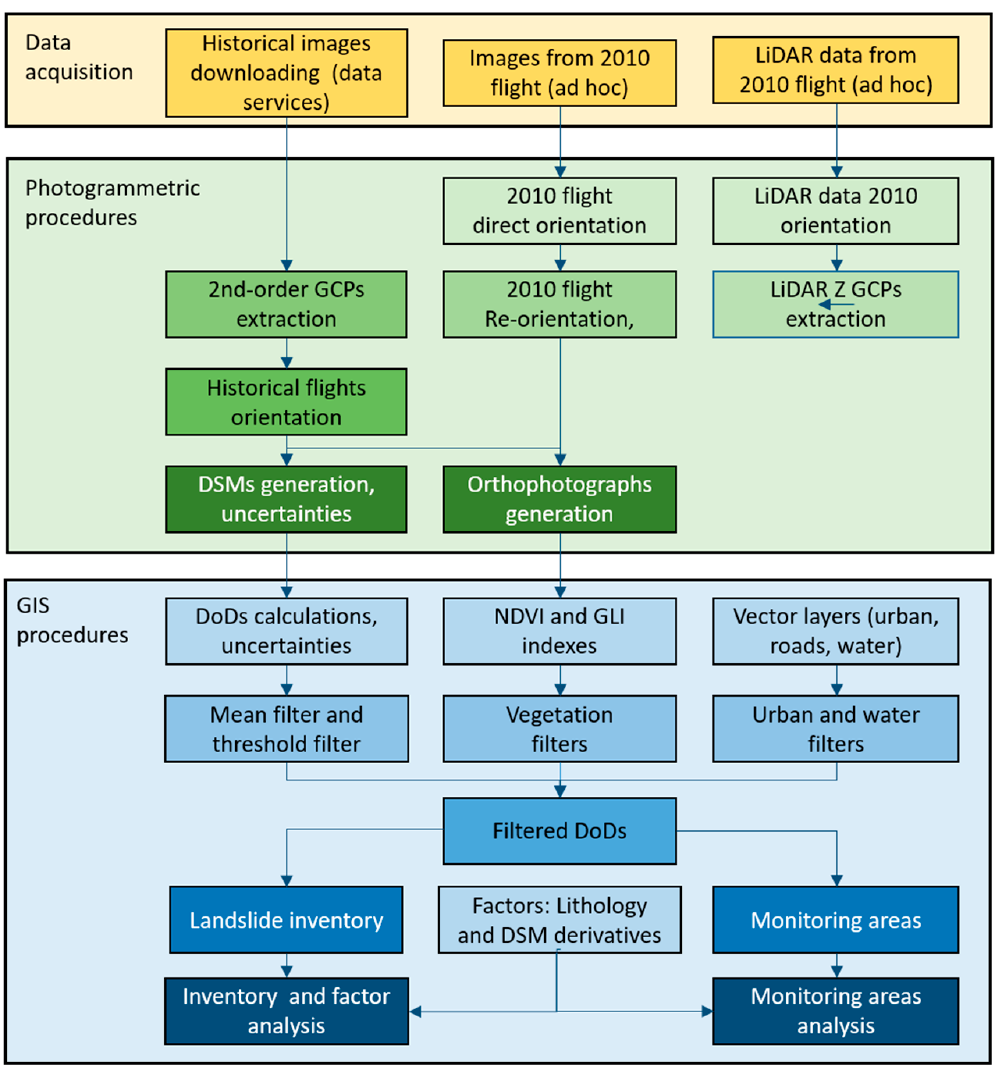
Figure 3. Methodology workflow.